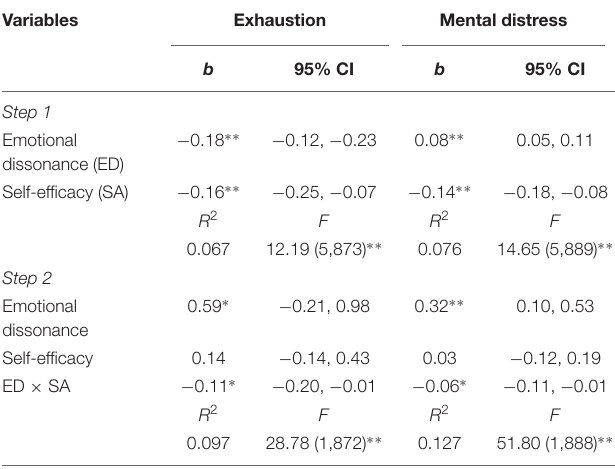
TABLE 2 | Estimates of the main and interaction effects of emotional dissonance and self-efficacy on exhaustion and mental distress.